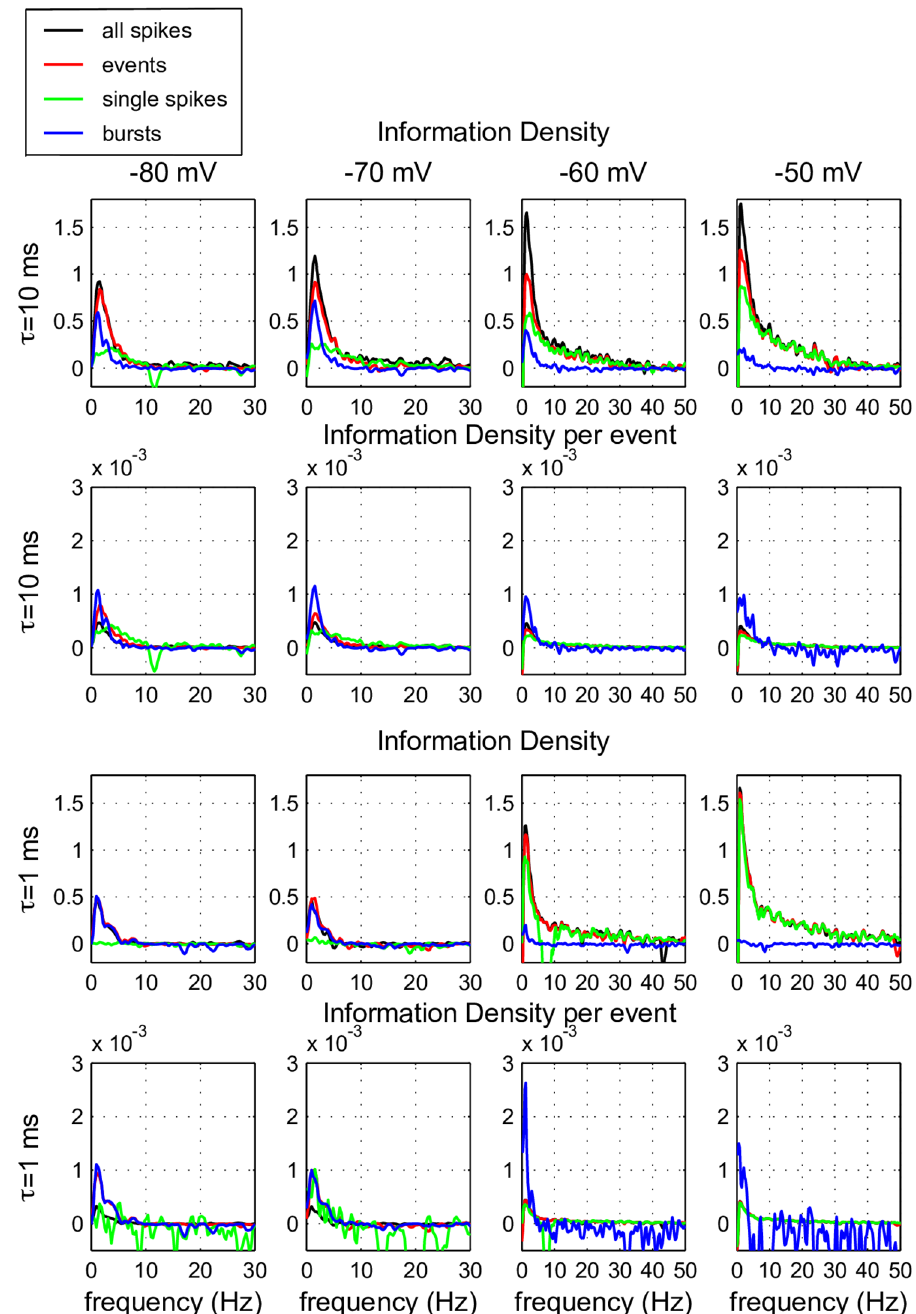
Fig 5. Information density carried in the TCR output signal. Typical example of the information density as a function of frequency calculated for several relevant components in the output signal of a TCR cell at the four different membrane states (left to right as defined in Fig 3). Two different input signals were used, both contained the same frozen Gaussian noise, filtered with an exponential filter with a time constant of either τ = 10 ms (top two rows) or τ = 1 ms (bottom two rows). We calculated the information density for each isolated spike (green), each burst (blue), each event (red = either isolated spike or burst) and all spikes (black, isolated or contained in a burst). The information density was calculated either per type of activity (row 2 and 4) or over the full trace (row 1 and